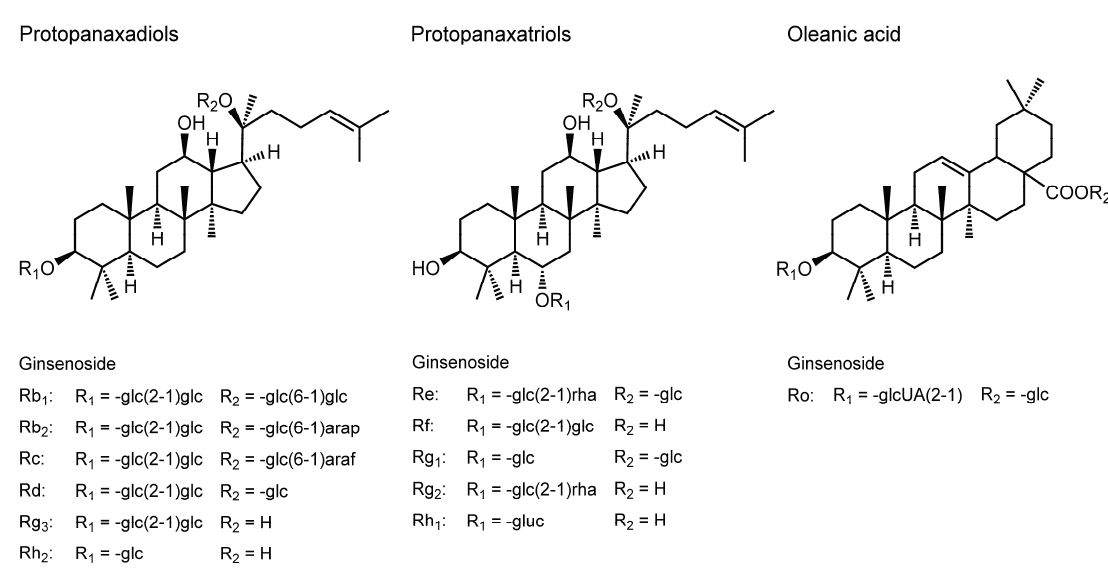
Figure 9. Structures of membrane-interactive